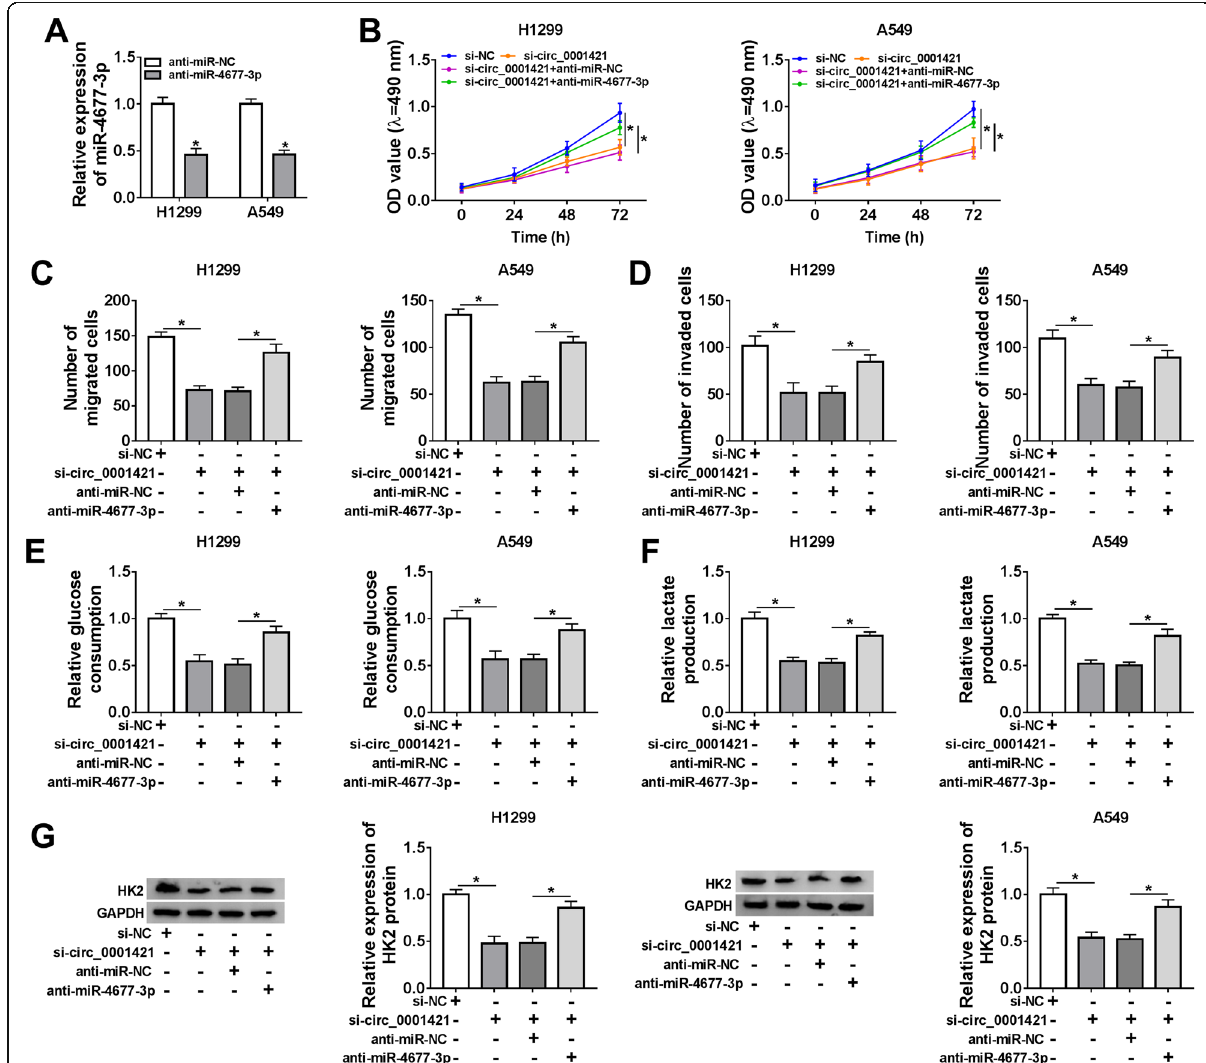
Fig. 4 Circ_0001421 regulated LC cell progression by adsorbing miR-4677-3p in LC cells. a The expression of miR-4677-3p in H1299 and A549 cells transfected with anti-miR-NC or anti-miR-4677-3p was detected by qRT-PCR. b-g H1299 and A549 cells were transfected with si-NC, si- circ_0001421, si-circ_0001421 + anti-miR-NC or si-circ_0001421 + anti-miR-4677-3p. b MTT assay was employed to analyze cell proliferation. c-d Cell migration and invasion were evaluated by Transwell assay. e-f Glucose consumption and lactate production were assessed by a Glucose assay kit and a Lactic Acid assay kit. g Western blot was used to check the protein expression of HK2. * P <